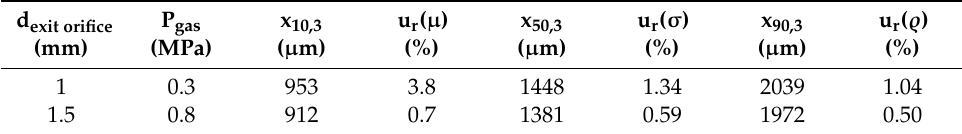
Table 2. Mean values and the corresponding uncertainty values u r (x) of x 10,3 , x 50,3 , x 90,3 for measurements of apparent droplet sizes, caused by beam